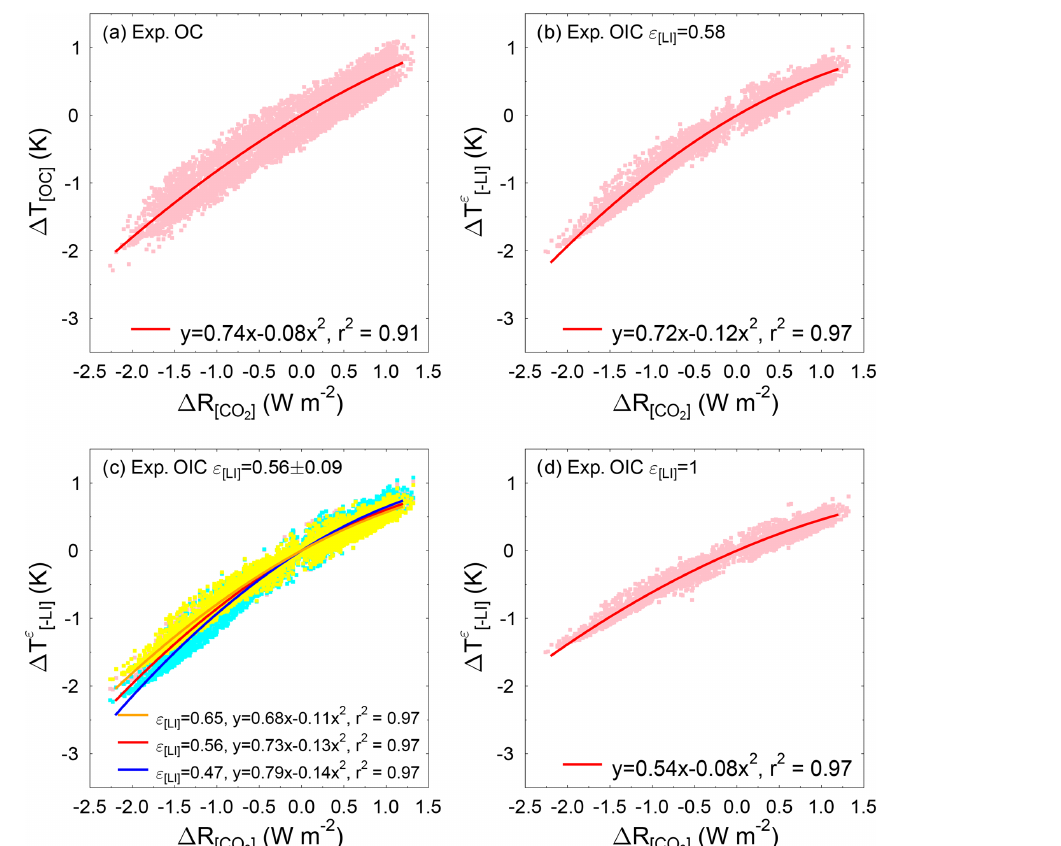
Figure 3. Temperature anomalies with respect to PI over the last 5Myr from CLIMBER-2 (Stap et al., 2018a) against imposed radiative forcing of CO 2 . (a) Simulation with fixed PI land ice distribution (experiment OC) ( (cid:49)T [ OC ] ). (b) Calculated global temperature perturbations from experiment OIC stripped of the inferred influence of land ice ( (cid:49)T ε [− ) using Eq. (16) with ε [ LI ] = 0 . 58. Here, ε [ LI ] is obtained from LI ] matching climate sensitivity with the target value at the LGM. (c) Same as in panel (b) but using ε [ LI ] = 0 . 47 (cyan dots), ε [ LI ] = 0 . 56 (pink dots), and ε [ LI ] = 0 . 65 (yellow dots), Here, ε [ LI ] is obtained from the mean ( ± 1 σ ) of matching climate sensitivity with the target value at all glacial marine isotope stages of the past 810kyr (MIS 2, 6, 8, 10, 12, 14, 16, 18, and 20). (d) Same as in panel (b) but using ε [ LI ] = 1, which is equivalent to the PALAEOSENS approach where efficacy differences were not considered. The red lines – and in panel (c) also the orange and blue lines – represent second-order polynomial least-squares regressions through the scattered